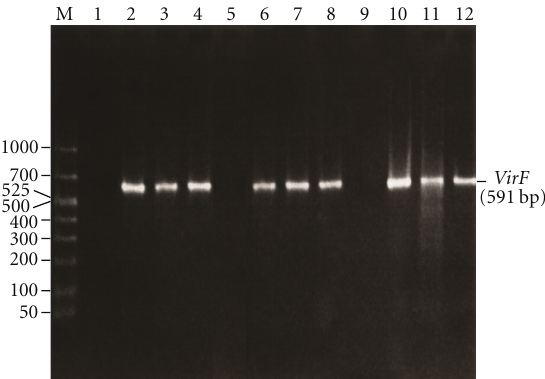
Figure 1: Confirmation of the presence of pYV in the original strains, cells in red pinpoint colonies, and cells in the white border around a red pinpoint colony from CR-MOX by PCR assay targeting a key regulatory gene virF , which encodes a transcriptional activator for the expression of pYV-encoded outer membrane protein Yop51. The primer pairs (5 (cid:3) -TCATGGCAGAACAGCAGTCAG-3 (cid:3) and 5 (cid:3) - ACTCATCTTACCATTAAGAAG-3 (cid:3) ) for detection of the virF gene (430- to 1020-nucleotide region) amplified a 591 base pair (bp) product from the virulence plasmid. Lane M, 50–1,000 bp ladder marker; lanes, 1, 5, and 9 showing the absence of 591-bp product in cells of the white borders of Y . enterocolitica , Y . pseudotuberculosis , and Y . pestis, respectively; lanes 2, 6, and 10 showing the presence of 591-bp product in the original strains of Y . enterocolitica , Y . pseudotuberculosis , and Y . pestis respectively before phenotypic evaluation; lanes 3, 7, and 11 showing the presence of 591-bp product in cells of the red pinpoint colonies of Y . enterocolitica , Y . pseudotuberculosis , and Y . pestis, respectively, and lanes 4, 8, and 12 showing the presence of 591-bp product within cells of red pinpoint colonies surrounded by white border of Y . enterocolitica , Y . pseudotuberculosis , and Y . pestis respectively